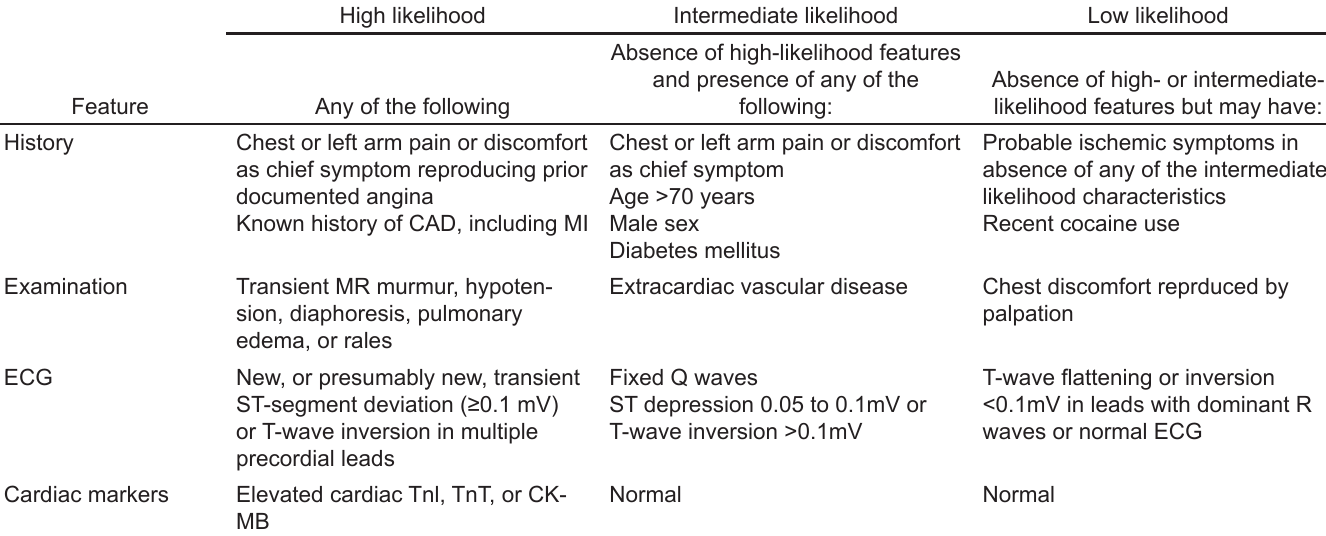
Table 1. AHA/ACC/ACEP risk stratification for